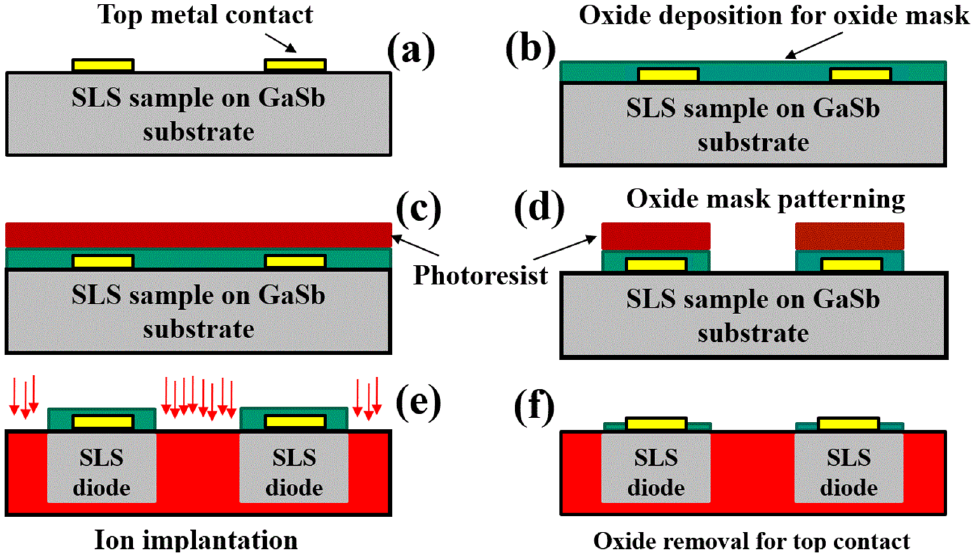
Figure 1. Schematic diagram of the process flow for the fabrication planar SLS photodetectors: ( a ) top metal contact, ( b ) deposition of the oxide mask, ( c , d ) patterning via photolithography, ( e ) implantation for diode isolation, and ( f ) top metal contact window opening.